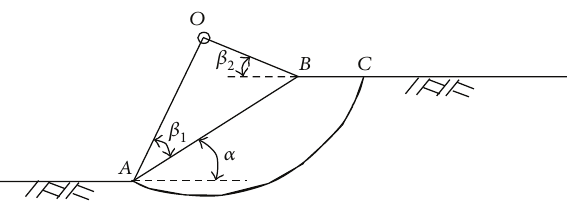
Figure 6. In Figure 6, point 𝐸 is determined by angles 𝛽 1 and 𝛽 2 which can be determined by slope angle 𝛼 as in Table 13. The critical failure surface circle center may be